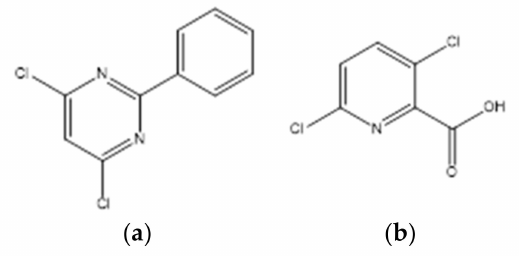
Figure 1. Structural formulas of the compounds studied in this work. ( a ) Fenclorim (4,6-dichloro-2-phenylpyrimidine); ( b ) Clopyralid (3,6-dichloro-2-pyridinecarboxylic